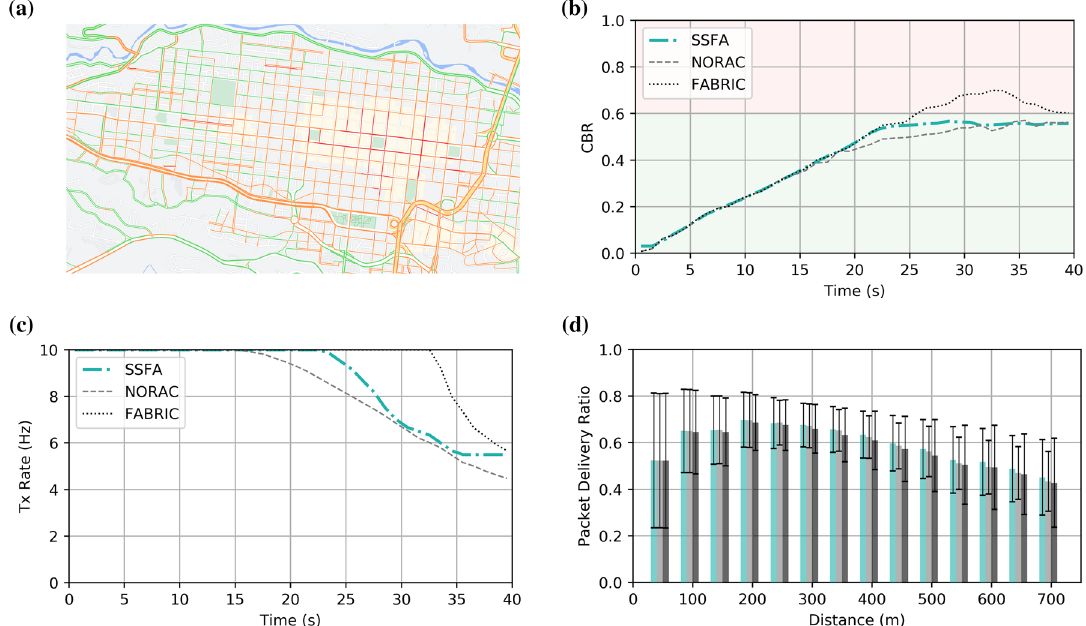
Figure 5. Realistic urban simulation (OMNeT ++ and SUMO) of the proposed congestion control approach compared to FABRIC and NORAC. ( a ) Traffic map (Map data ©2021 Google) of the city of Pereira (Risaralda, Colombia), used in the simulations, illustrating different levels of congestion (from low; green, to high; red) during the peak period (4 p.m.); ( b ) CBR measured and ( c ) allocated beaconing rate of a sample vehicle over time; ( d ) average packet delivery ratio for different vehicles over